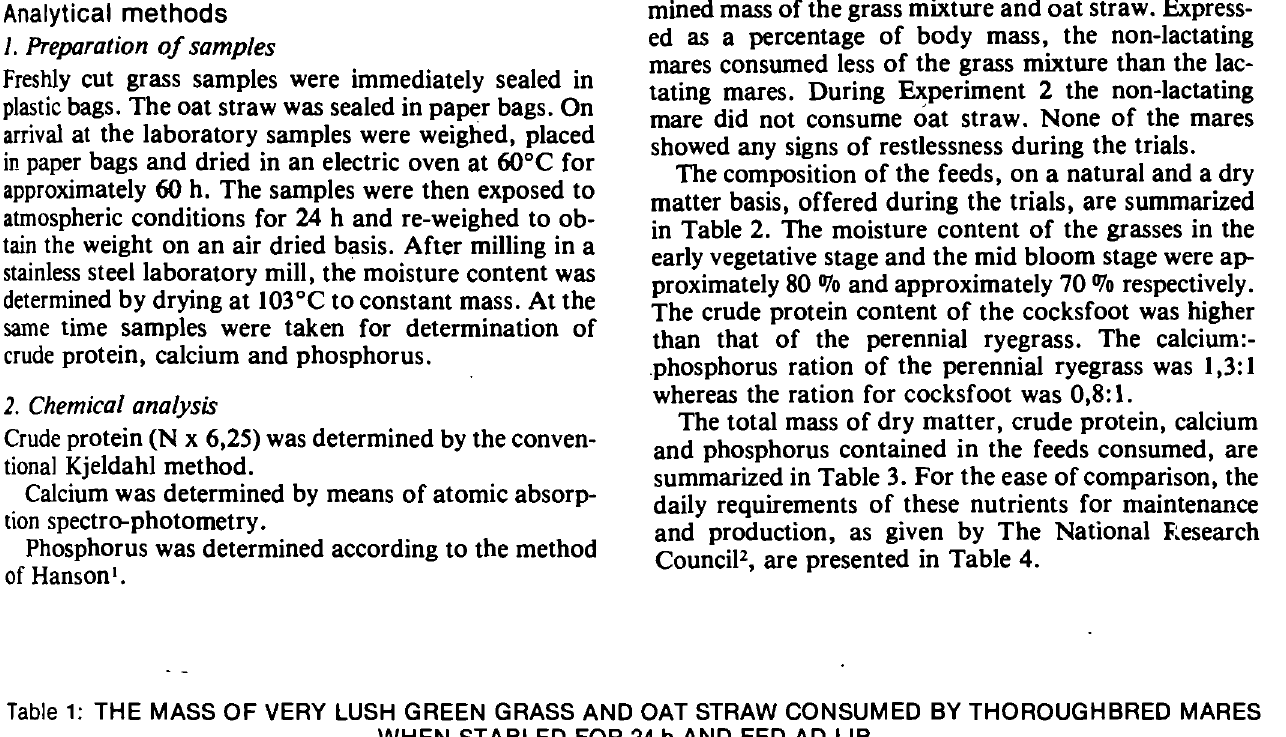
Table 1: THE MASS OF VERY LUSH GREEN GRASS AND OAT STRAW CONSUMED BY THOROUGHBRED MARES WHEN STABLED FOR 24 h AND FED AD LIB.